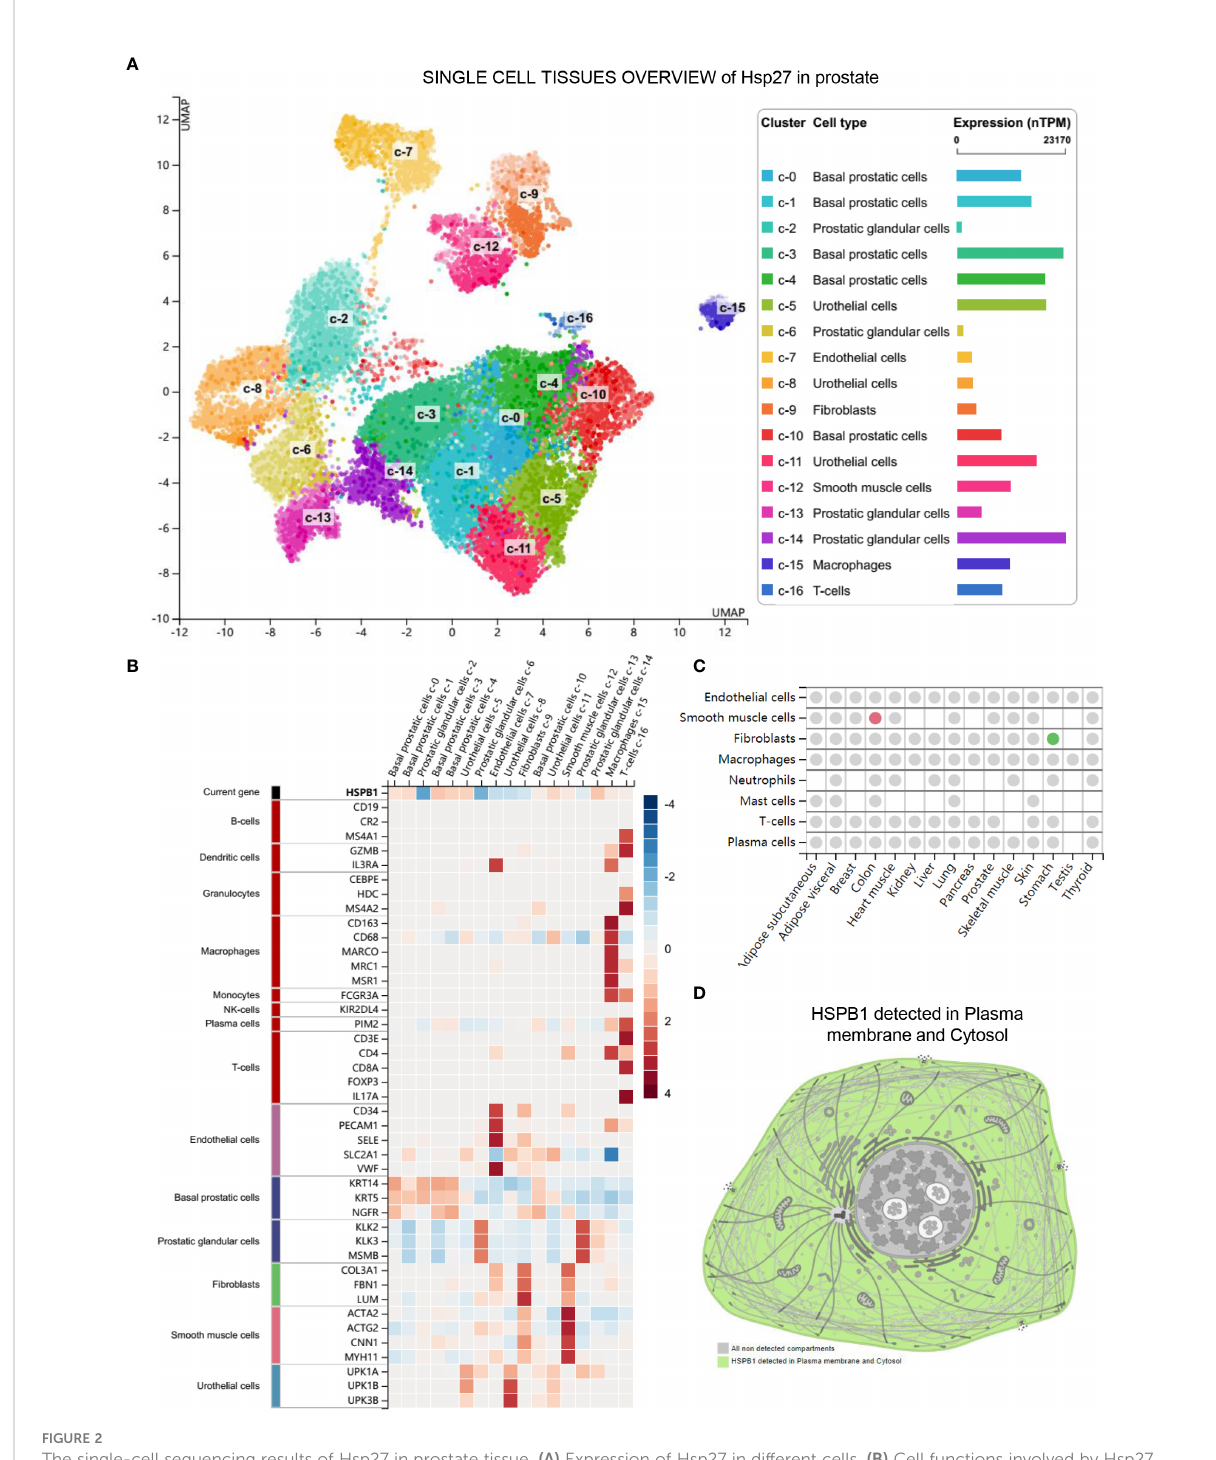
FIGURE 2 The single-cell sequencing results of Hsp27 in prostate tissue. (A) Expression of Hsp27 in different cells. (B) Cell functions involved by Hsp27. (C) Hsp27 affects the functions of Fibroblasts. The analysis results showed that Hsp27 may be related to tumorigenesis and development. (D) Hsp27 (HSPB1) detected in Plasma membrane and